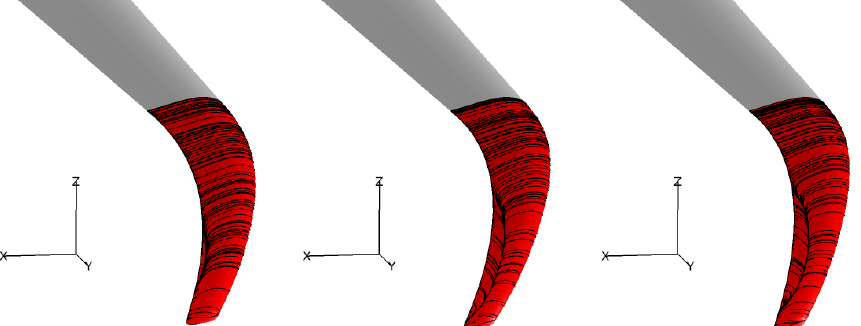
Figure 16. A sequence of three different deforming curved tip shapes (red) imposed on the baseline blade (gray) where surface-restricted streamlines can be seen as thin black lines. The flow visualization shows an emerging stall region leading to the impaired flow convergence. Shedding of vorticity is introduced as the blade is further twisted. These shapes were created by the optimizer during an early exploratory optimization. They are easier to solve with, for example, unsteady methods, and the design space was therefore limited enough to avoid the stall